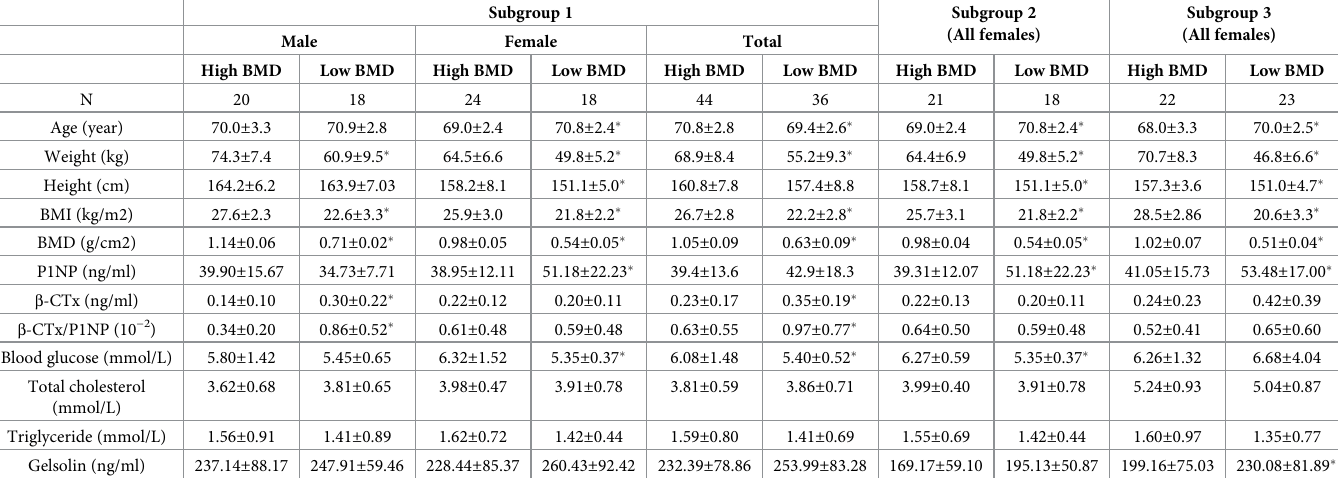
Table 1. Basic characteristics of the three independent extreme samples (Subgroups 1–3).